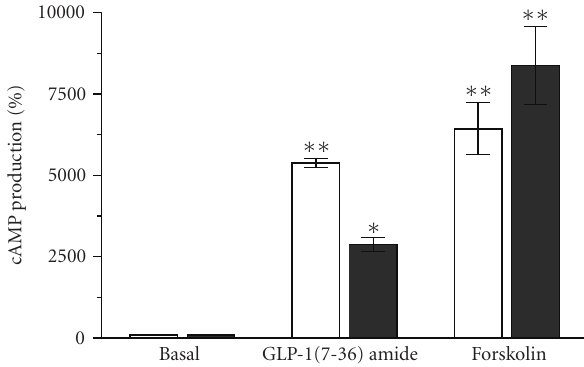
Figure 6: E ff ect of GLP-1(7-36)amide and forskolin on the produc- tion of cAMP from CHO cells transiently expressing GLP-1 receptor and GFP-GLP-1 receptor. GLP-1 receptor (empty bar); GFP-GLP-1 receptor (filled bar). 100% = 56 . 8 fmol/mg and 37.7 fmol/mg for GLP-1 receptor and GFP-GLP-1 receptor, respectively (basal value, no ligand added). Each bar with the indicated standard deviation represents the mean value of three independent experiments done in duplicate. ANOVA: F(5, 12) = 98 . 14; P < .0001. Tukey-Kramer multiple comparison test was used to reveal significant di ff erences between groups of interest. See Results for the